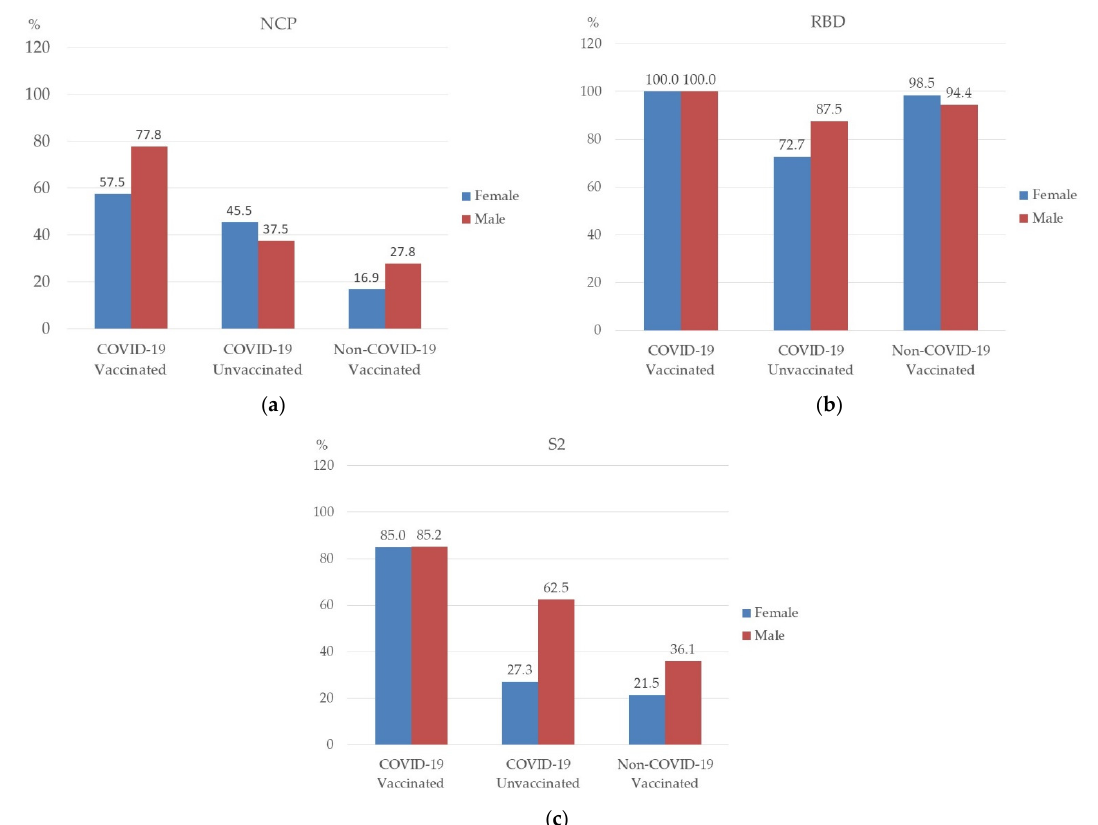
Figure 2. Prevalence of NCP ( a ), RBD ( b ), and S2 ( c ) antibody by sex among the studied groups.